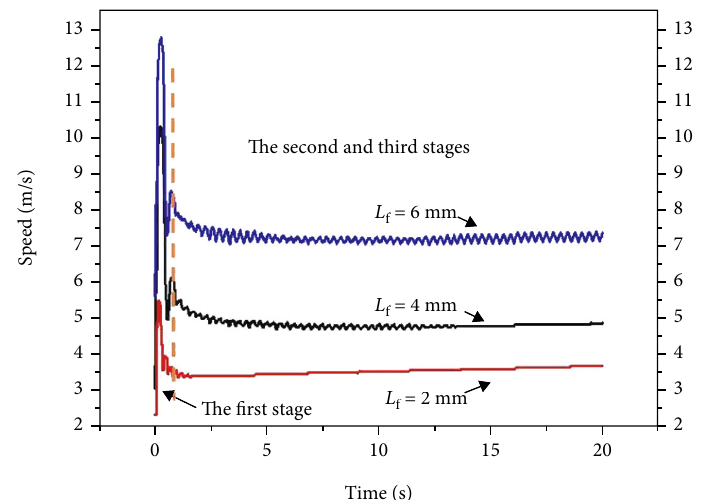
Figure 8: In fl uence of fracture aperture L